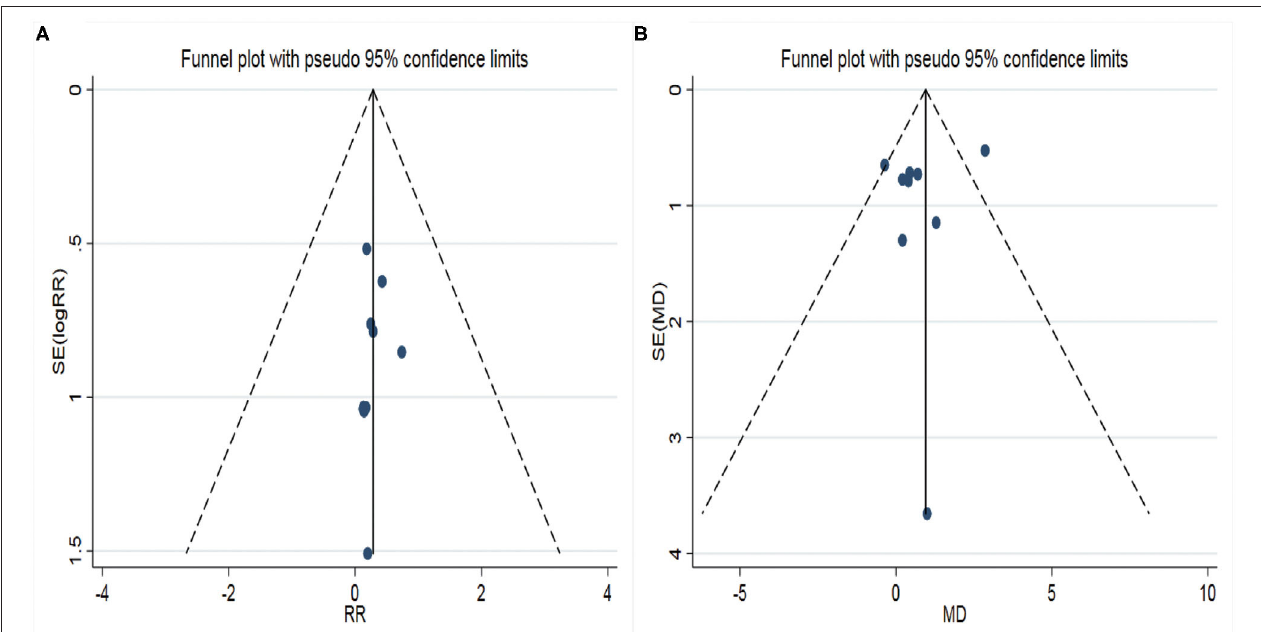
FIGURE 4 | Funnel plots of two surgical procedures with associated outcome indicators ( A : postoperative complications; B : Böhler angle). RR, relative ratio; SE, standard error; MD, mean difference. X-axis represents relative ratio (RR); Y-axis represents the standard error of log